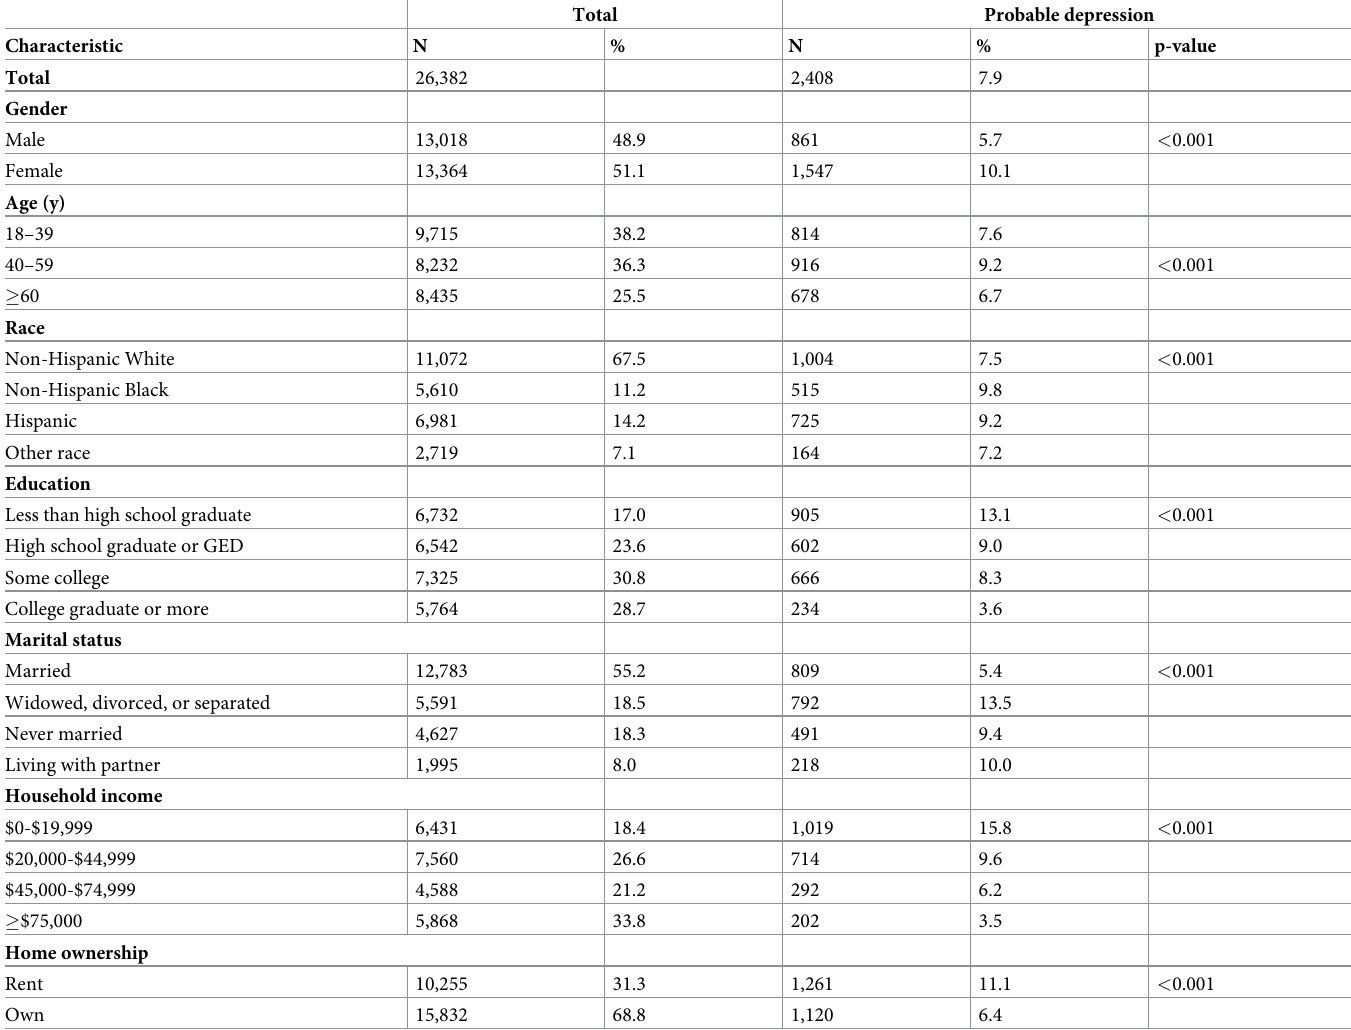
Table 1. Characteristics in study sample (N =